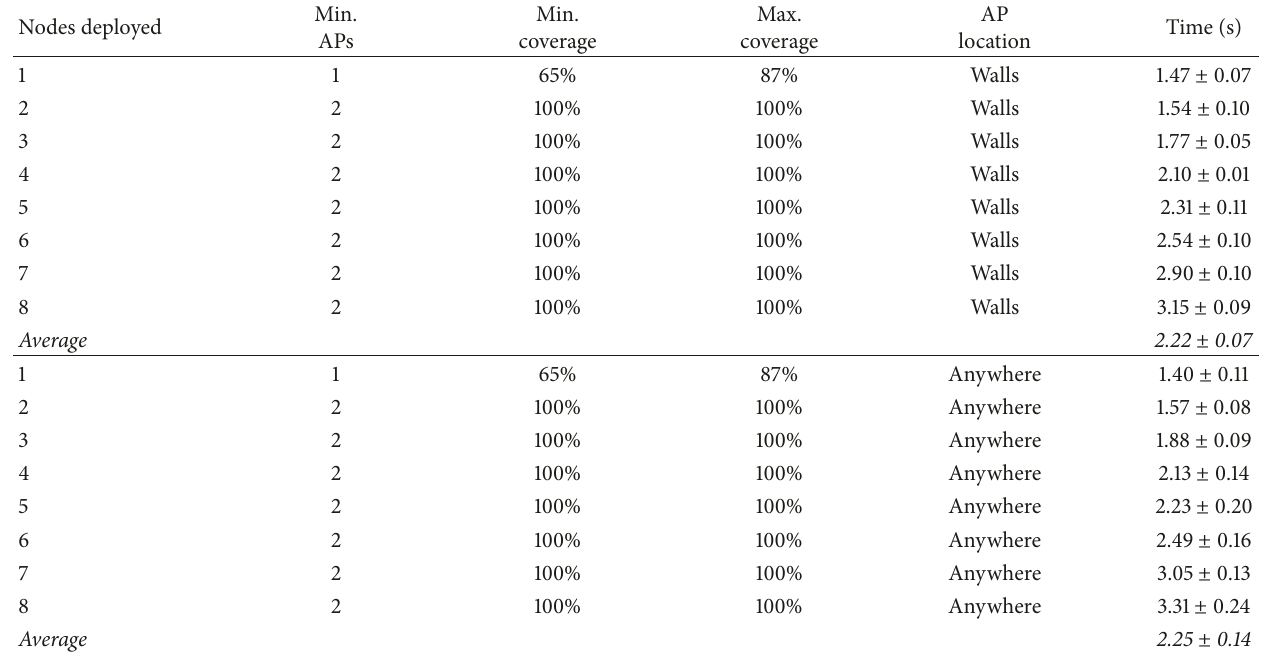
Table 5: Performance of NSGA-II in a small scenario.